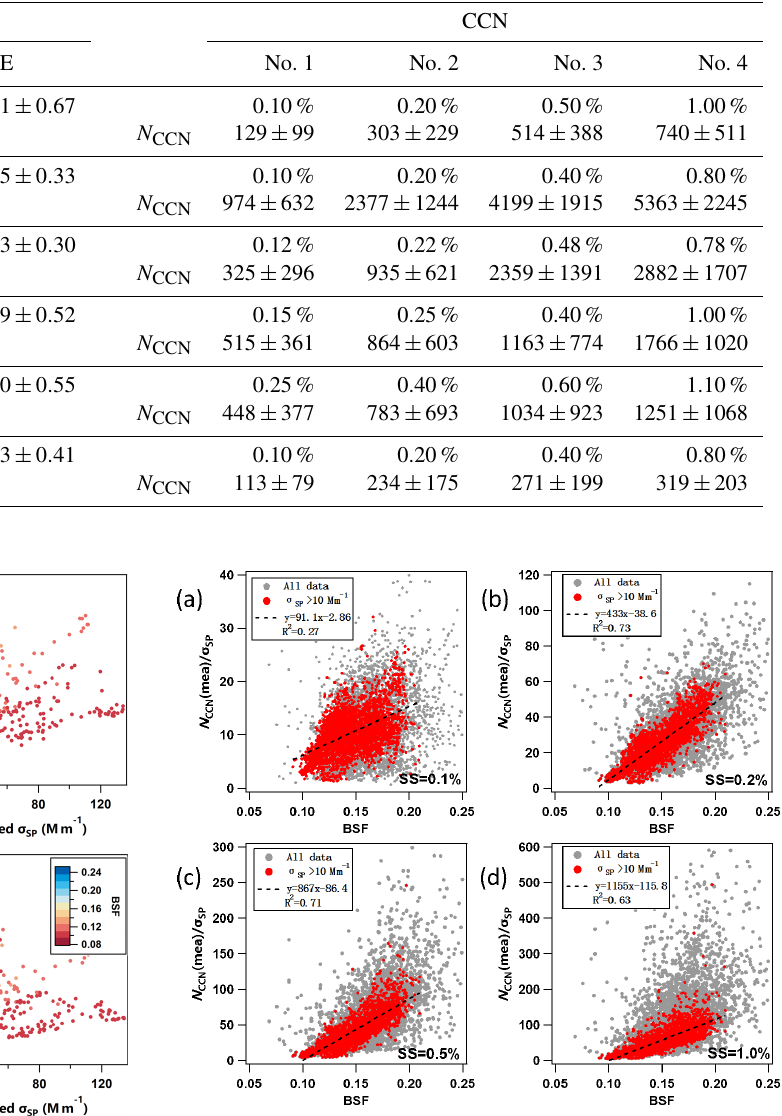
Table 2. Descriptive statistics of AOPs of PM 10 aerosol and N CCN at the different sites. σ sp : total scattering coefficient of green light ( λ = 550 or 525nm), in reciprocal megameters; BSF: backscatter fraction of green light; SAE: scattering Ångström exponent between blue and red light. The N CCN statistics in number per cubic centimeter are presented for four supersaturations (SS) at each site.The numbers are the averages and standard deviations.